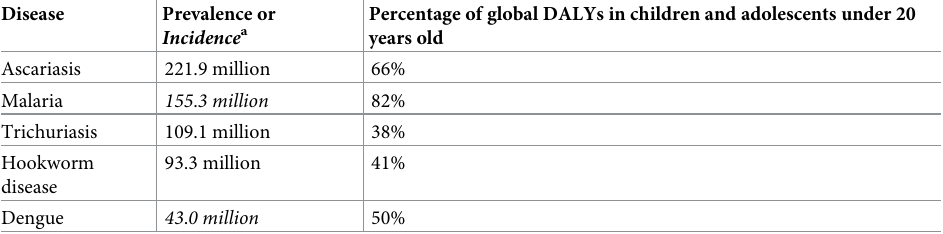
Table 2. Prevalence or incidence of tropical infections in children and adolescents under 20 years old (informa- tion from [1–4]). Disease